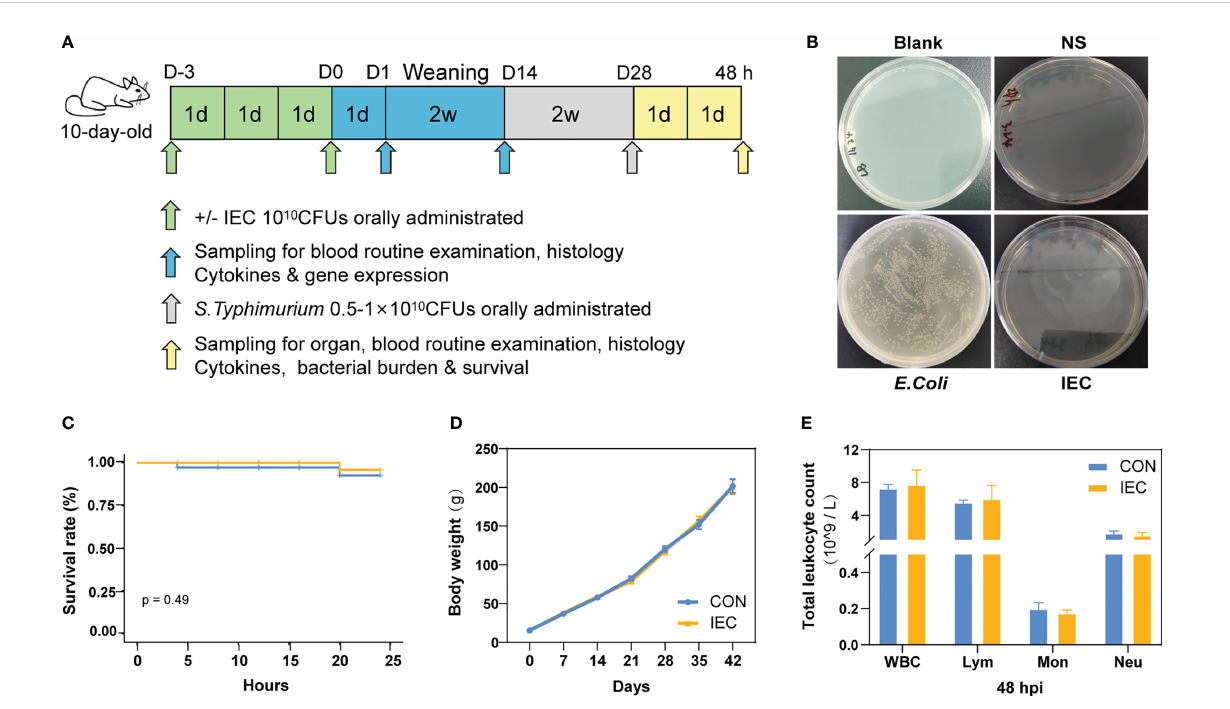
FIGURE 1 Study design and protective effect of IEC against Salmonella infections. (A) Schematic diagram of the experimental procedure. (B) IEC inactivation effect test. (C) Rats survival rate was recorded for 24 hours Salmonella infection (n =12/group). (D) The body weights of rats during the whole experiment (n = 10~18/group). (E) Counts of leukocyte were detected by blood routine examination at 48 hpi (n = 10/group). The data are presented as mean ± SEM. WBC, white blood cell; Lym, lymphocyte; Mon, monocyte; Neu, neutrophilicgranulocyte; hpi, hours post